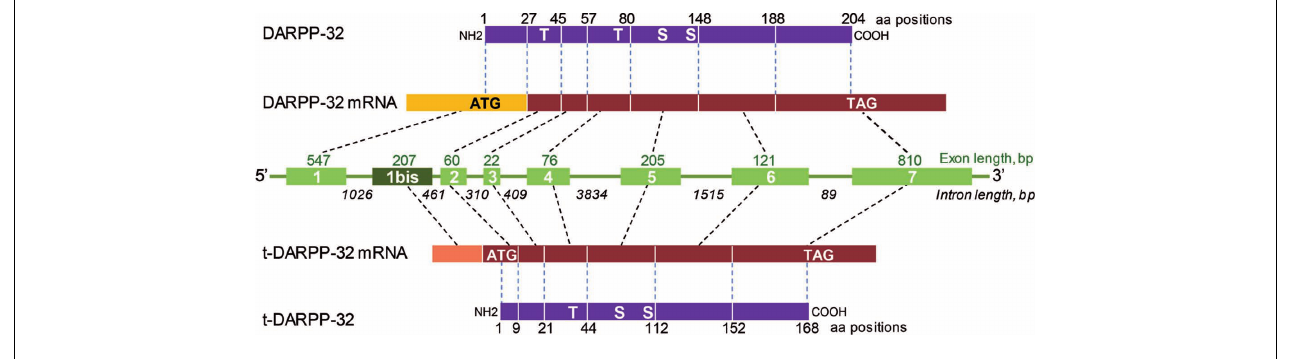
of exons and introns is indicated in base pairs (bp) and the borders of coding exons in amino acid residues in protein sequences.The position of major phosphorylation sites is indicated on the proteins (S, serine,T, threonine).The scheme is based on El-Rifai et al. (2002) and NCBI